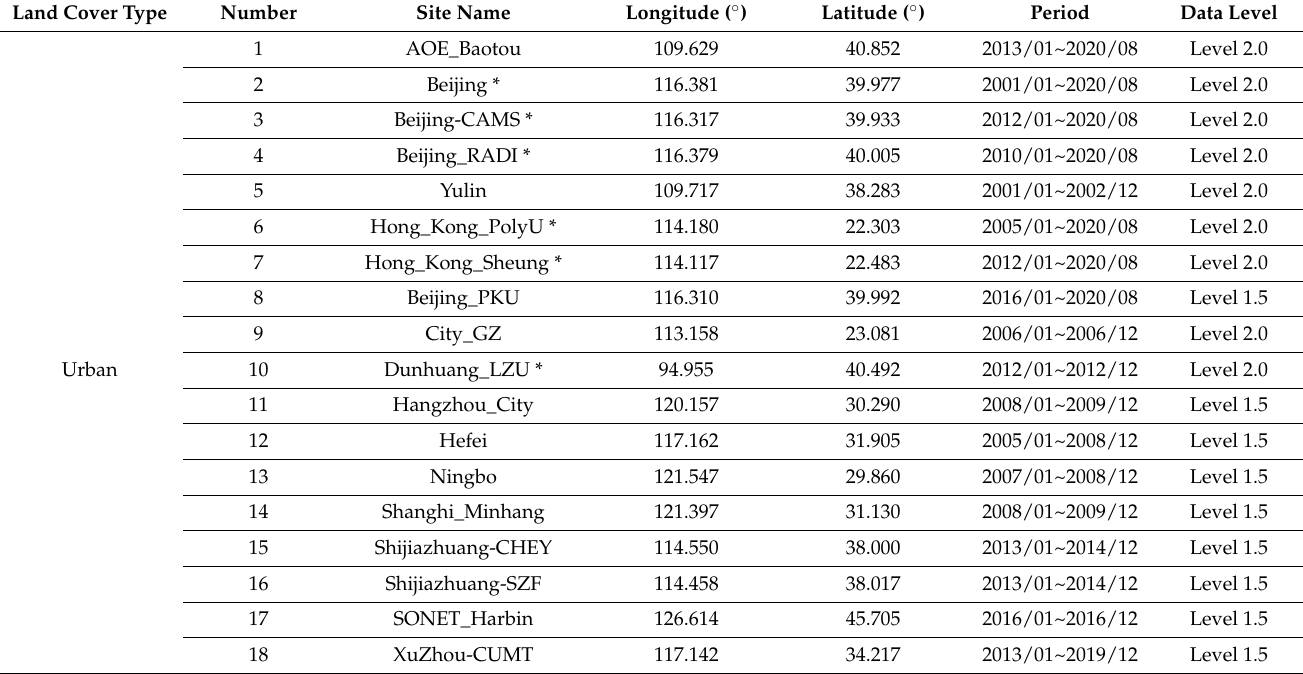
Figure 1. Distributions of AERONET sites in China. Table 3. Details of AERONET sites in China.